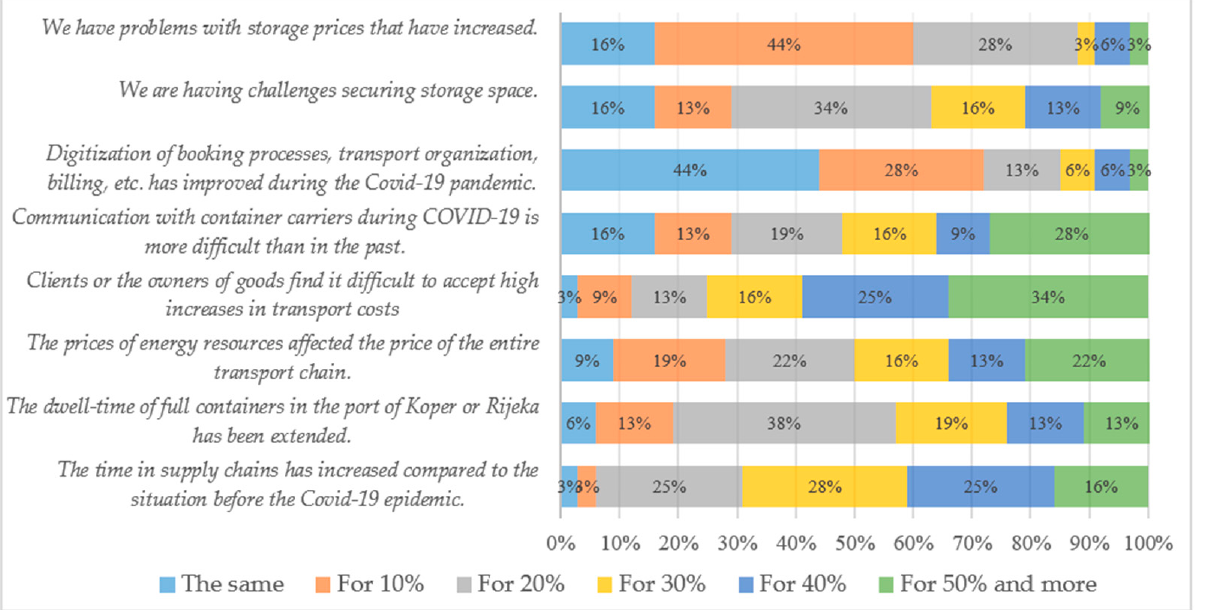
Figure 2. Changes in port logistics during the COVID-19 pandemic.